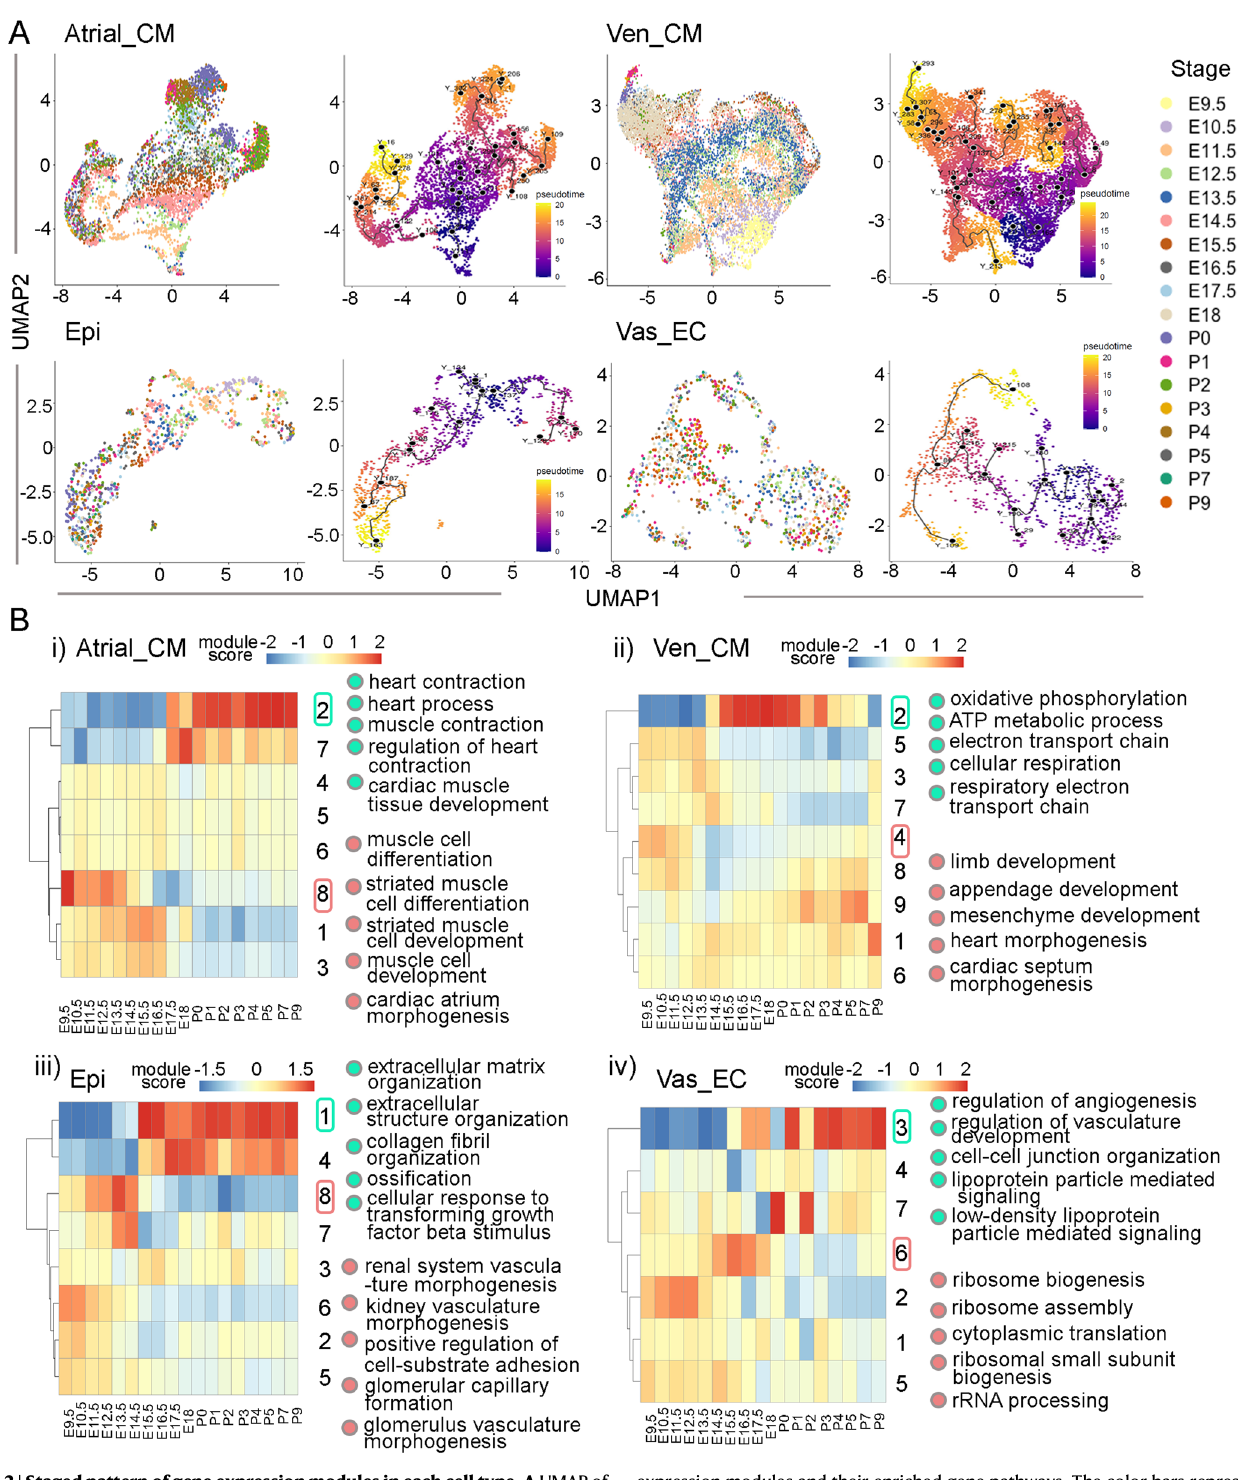
expression modules and their enriched gene pathways. The color bars represent module